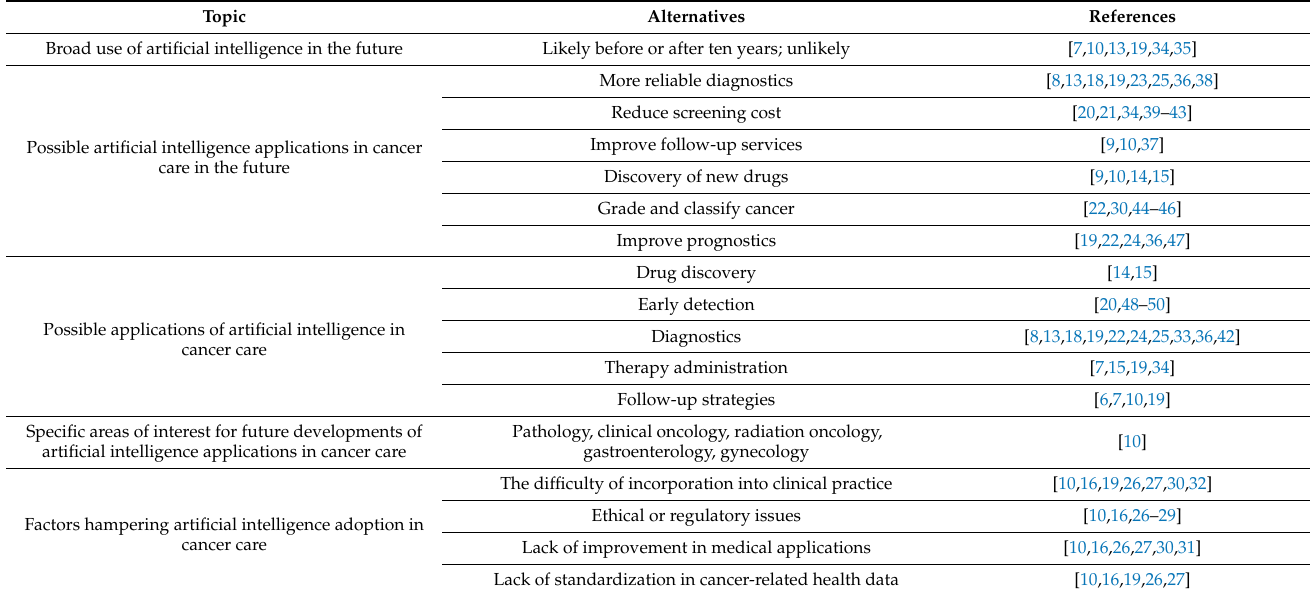
Table 1. References used in the development of the survey